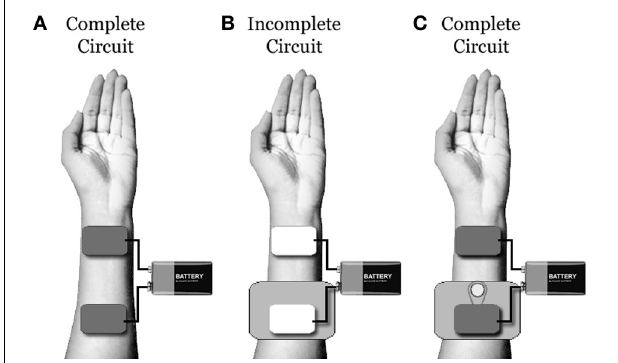
FIGURE 1 | (A) Under typical conditions, one will be able to build an electric circuit using two saline soaked tDCS sponges placed on a piece of clean skin. (B) When a piece of non-conductive plastic is placed underneath one electrode, the circuit will be broken. (C) When a small hole is cut in the plastic and a small stream of saline is used to connect the skin under the hole to the electrode, the circuit will be re-built. This demonstrates that, even if a tDCS electrode is not in contact with the scalp, excessive saline can be used to bridge between the electrode and the skin. Unfortunately, with excessive saline, determining the location of the circuit connection and electrical density at this point is extremely